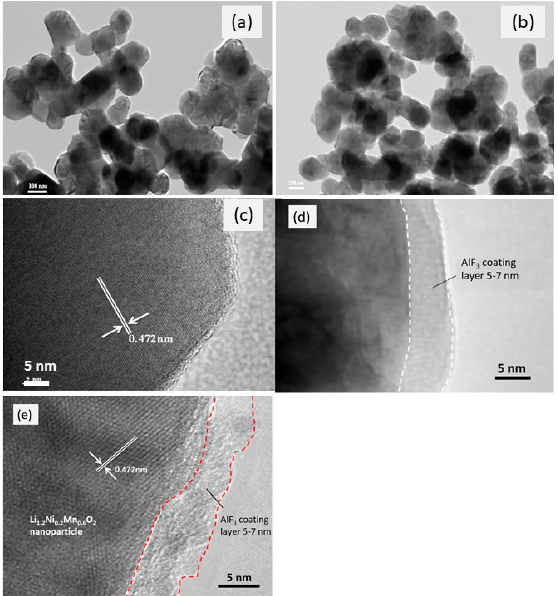
Figure 7. SEM images of ( a ) pristine LLNMO and ( b ) AlF 3 -coated LLNMO. ( c ) EDX spectrum of AlF 3 -coated LLNMO.